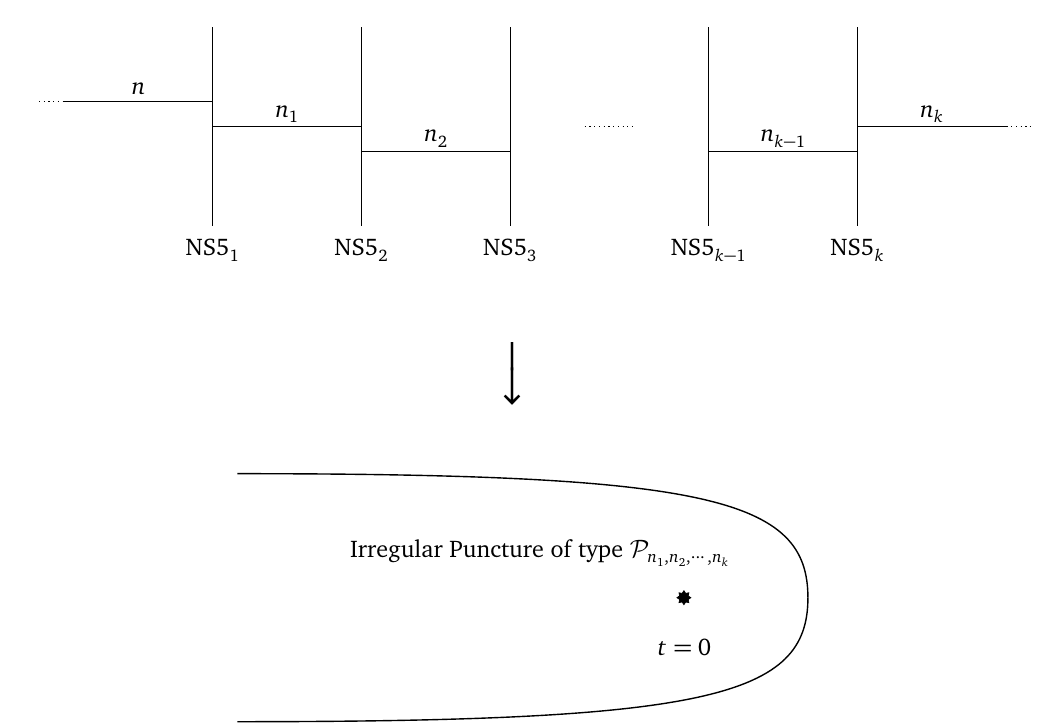
Figure 12: Top: k ≥ 1 parallel NS5 branes in Type IIA superstring theory with D4 branes stretched between them. All the branes share a common 4-dimensional space- time, and the preserved supersymmetry is N = 2. Here, n , n denote numbers of D4 i branes. The stacks of n D4 branes on the left and n D4 branes on the right are semi- k < n , then the above brane construction can be associated to infinite. Bottom: If n 1 ( 2,0 ) theory compactified on a cigar parametrized by an irregular puncture of A n − 1 a complex coordinate t with the puncture being located at t = 0. This puncture is referred to be of the type P n 1 , n 2 , ··· , n k